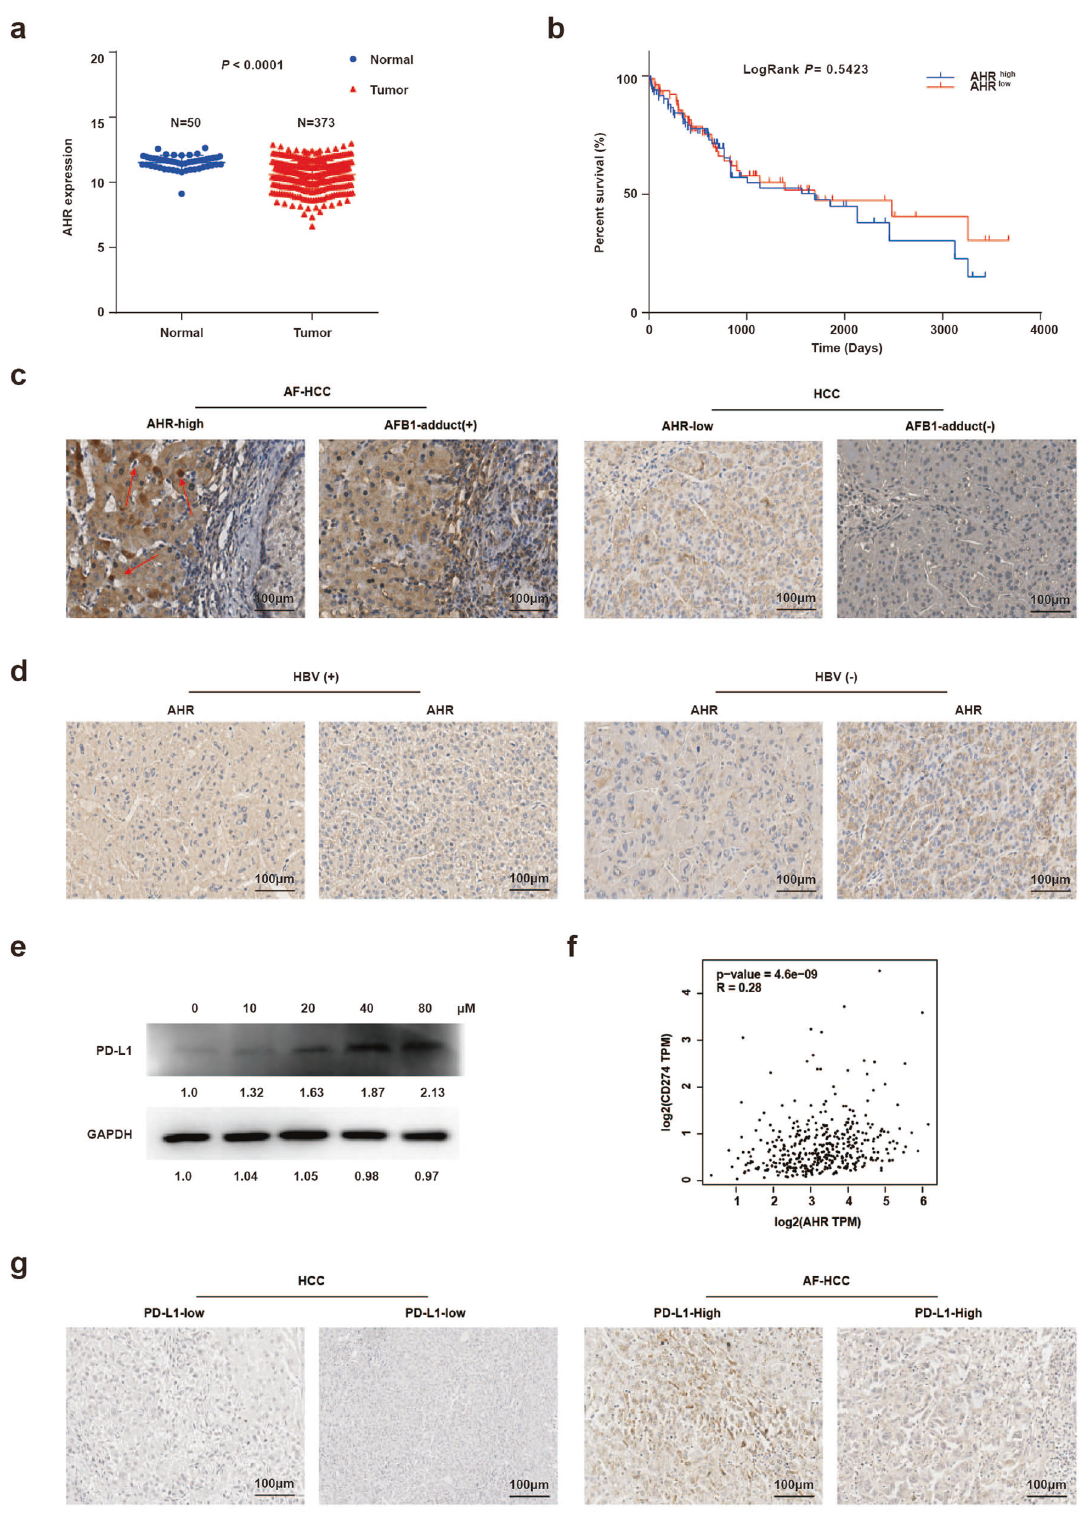
Fig. 6 AHR and PD-L1 are highly expressed in primary AFB1-associated hepatocellular carcinomas (AF-HCC). a AHR expression levels in HCC using the TCGA dataset ( n = 424) . b Kaplan – Meier plot for overall survival of hepatocellular carcinoma patients based on AHR expression levels in tumors from the TCGA dataset. High and low expression is based on the median level of AHR expression in all patients. c , d Images of immunohistochemical staining for AHR expression in hepatocellular tumors c with or without AFB1 exposure and d with or without HBV infection. e Western blot staining of PD-L1 in PLC/PRF/5 with increasing AFB1 concentrations treatment. f AHR and PD-L1 expression correlation analysis using data from the GEPIA server. g Images of immunohistochemical staining for PD-L1 expression in hepatocellular tumors with or without AFB1 exposure